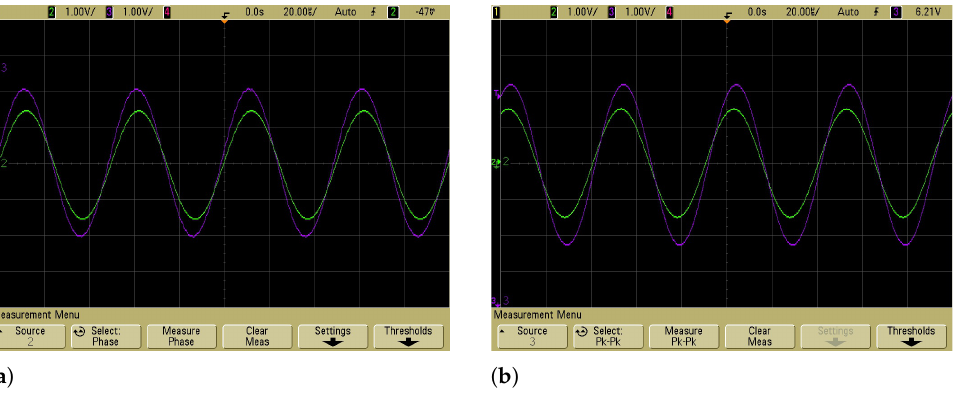
Figure 14. Input and output waveforms of inverse filters of order 0.26, realized by ( a ) the topology in Figure 5a, and ( b ) the topology in Figure 5b stimulated by a (3 V p-p , 20 kHz) sinusoidal input. In order to evaluate the effect of the choice of the series of capacitor values, let us consider the case that the capacitances are chosen from the E12 series. In the obtained sets are {100 pF, 220 pF}, {560 pF, 270 pF}, {100 pF, 10 pF}, and {560 pF, 560 pF} for the low pass, high pass, inverse low pass, and inverse high pass filters, respectively. The corresponding frequency responses are provided in Figure 15a–d, with the half-power frequencies being 23.5 KHz, 19.3 kHz, 24.1 kHz, and 20.1 kHz, respectively. Taking into account that the theoretically expected value is 20 KHz, it seems that the filter topologies have reasonable sensitivity characteristics.